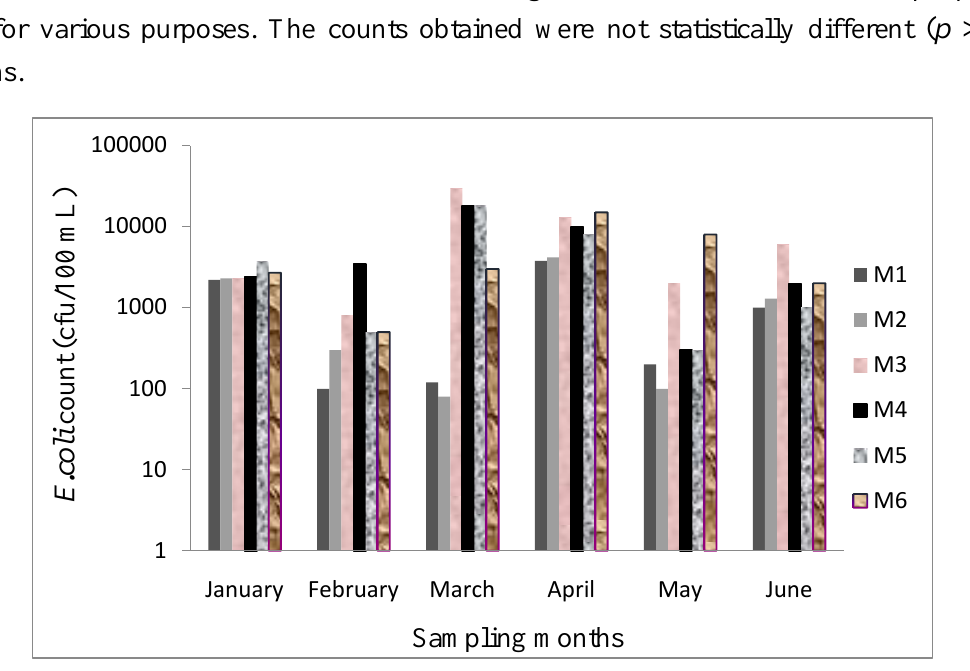
Figure 2. E.coli count in each sampling site of Mvudi River.